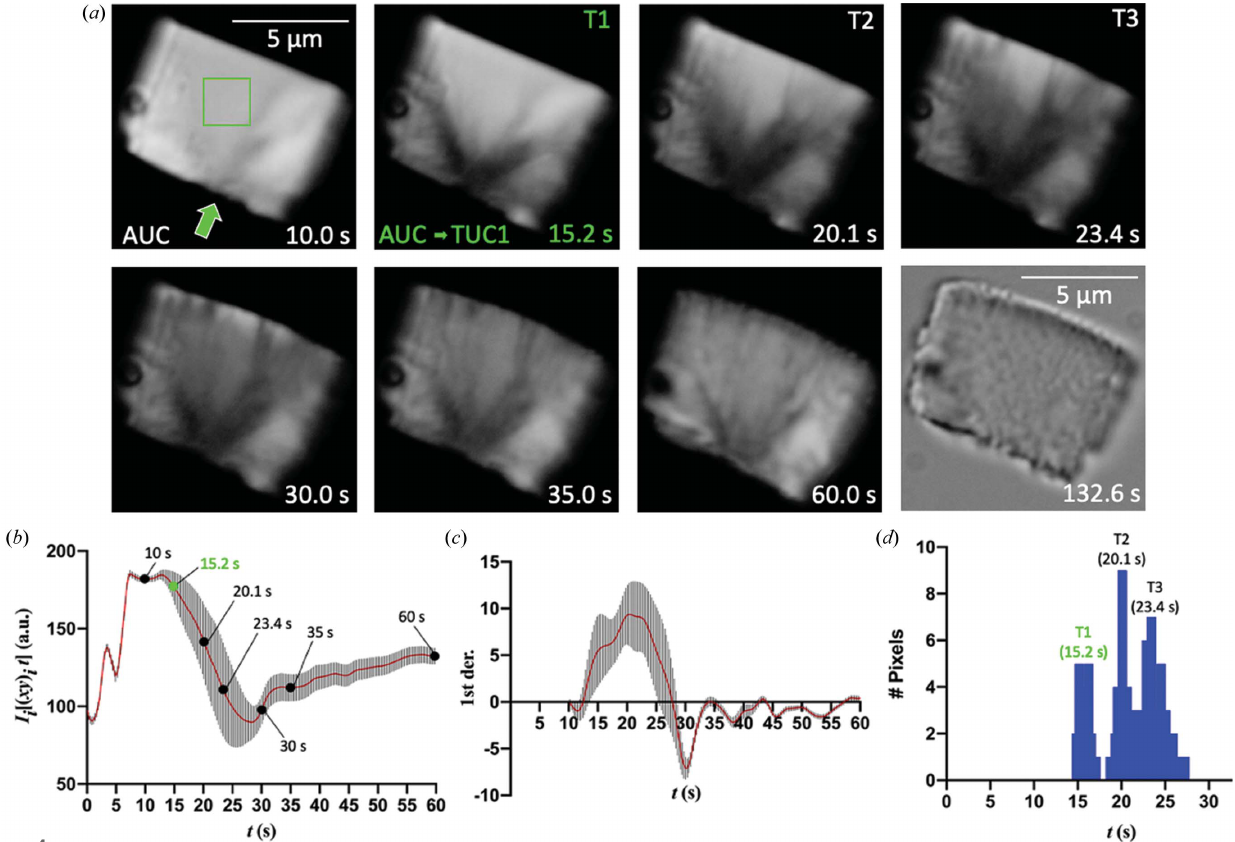
Figure 4 ( a ) PVM images of a riboA crystal (8 (cid:8) 6 m m) in the presence of 10 m M adenine ligand. A crystal defect, which serves as the point of origin for the phase transition, is indicated by the green arrow. ( b ) Averaged intensity of crystal birefringence for each spatially averaged (10 (cid:8) 10 pixels) superpixel in the selected ROI (80 (cid:8) 80 pixels, green square) plotted versus time. ( c ) The first derivative of the intensity plot in ( b ). ( d ) Histogram of the time values of the first-derivative peaks for all superpixels (64), revealing T1, T2 and T3. As the addition of ligand causes disturbance to birefringence intensity and view of the crystal under the microscope, measurements prior to 10 s were omitted from the